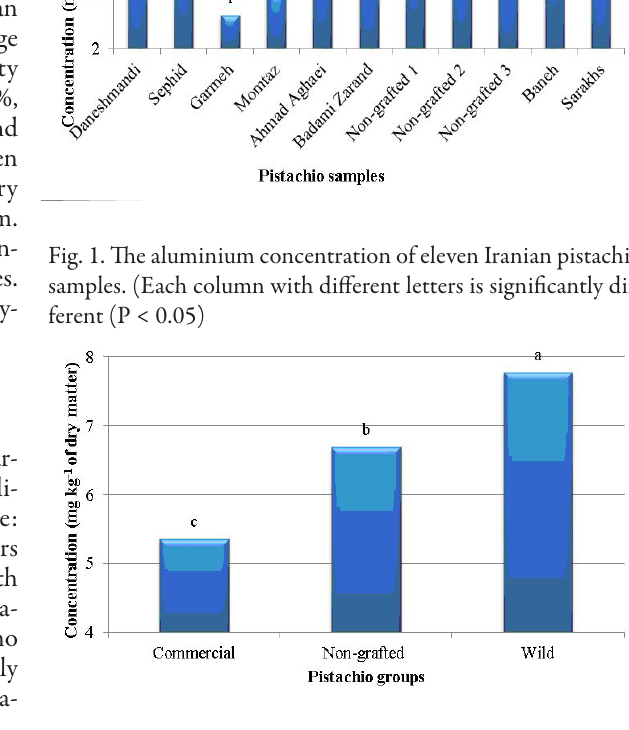
Fig. 2. The aluminium concentration of three Iranian pistachio groups. (Each column with different letters is significantly dif- ferent (P <